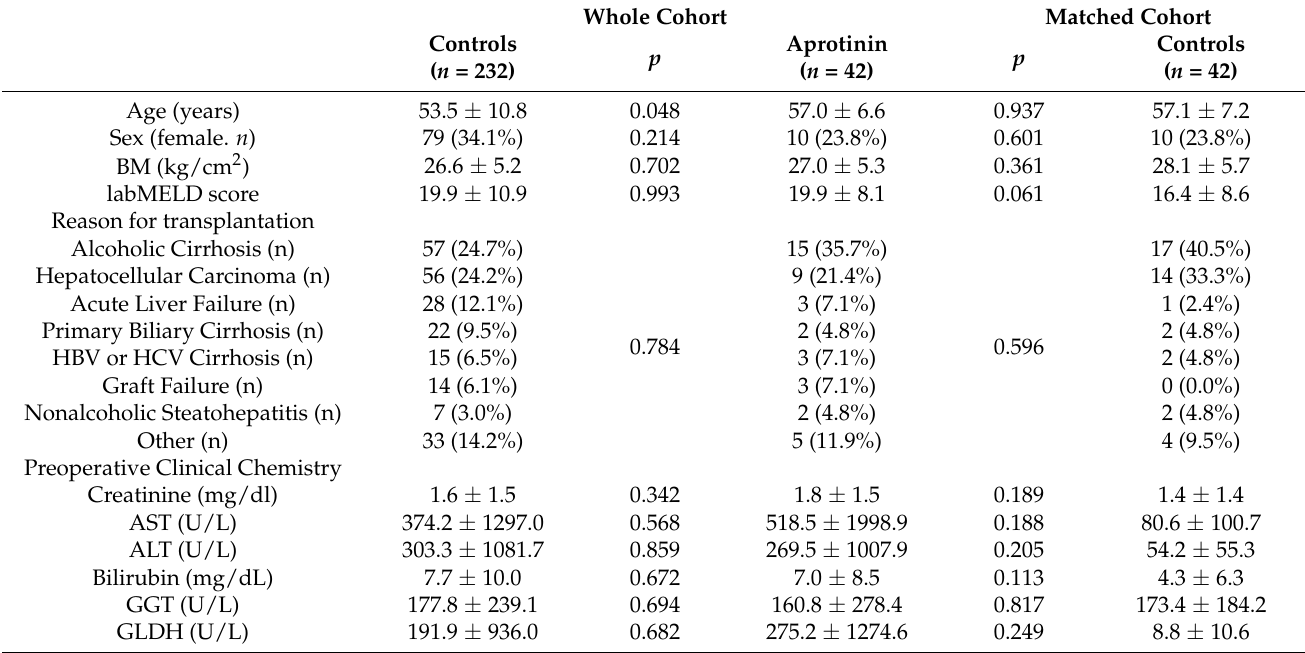
Table 1. Demographic and clinical characteristics of 42 liver graft recipients were intraoperatively treated with aprotinin and 42 controls. The 42 statistically similar recipients who were not treated with aprotinin were identified by propensity score matching in a cohort of 274 single center liver graft recipients. Propensity scores were calculated using organ quality, cold ischemia time and donor age.